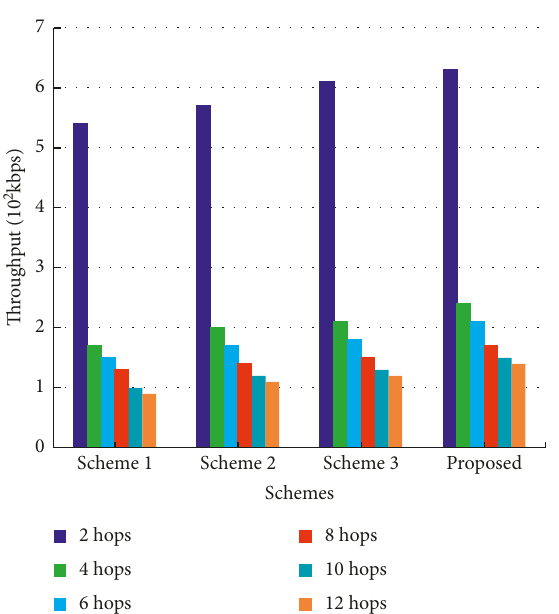
Figure 8: Transmission rates of the four schemes at different hop